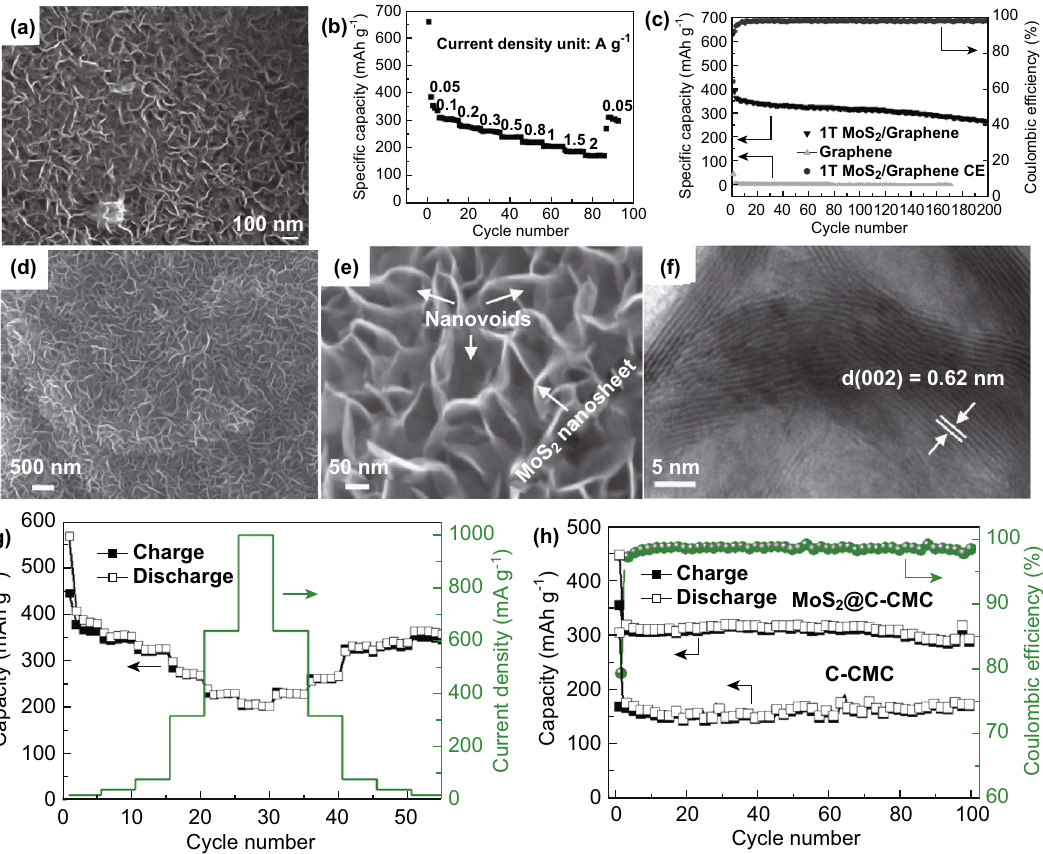
Fig. 16 3D architectures based on 2D transition metal nanoflakes on 3D skeleton ensembles for SIBs. a High-magnification image of 1T-MoS 2 on the internal surface of the tube. b Rate performance of the MoS 2 -graphene electrode. c Specific capacity and Coulombic efficiency versus cycle number at a current density of 50 mA g - 1 . Reproduced with permission [135]. Copyright (cid:2) 2017, John Wiley & Sons, Inc. d, e SEM images of the as-prepared freestanding MoS 2 @C. f High-magnification TEM image of MoS 2 @C. g Rate performance of MoS 2 @C-CMC electrode. h Cycling performance and corresponding Coulombic efficiency of MoS 2 @C-CMC paper electrode at 80 mA g - 1 and cycling performance of CMC-coated carbon paper electrode. Reproduced with permission [130]. Copyright (cid:2) 2016, John Wiley & Sons,